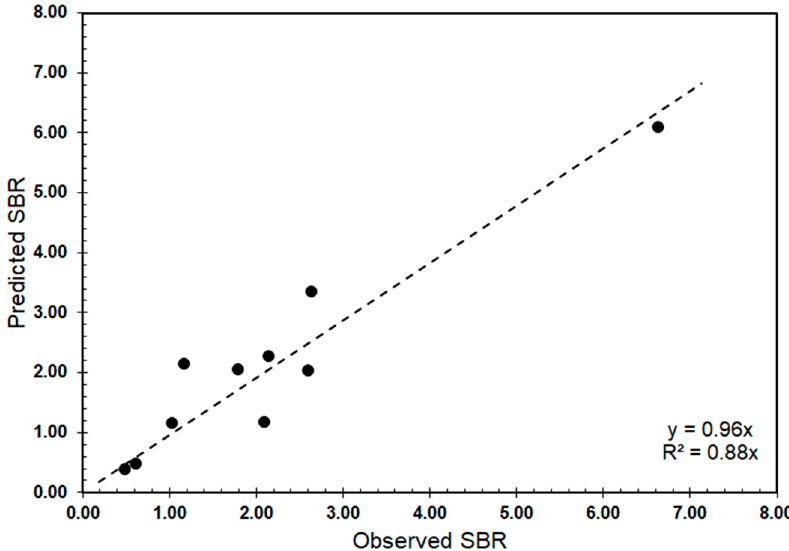
Figure 10. Scatter plot of the SBR determined in the laboratory from Dean–Stark analysis (True SBR) against the SBR predicted from the spectral model using froth spectra as an input. The dashed line represents the trend line.